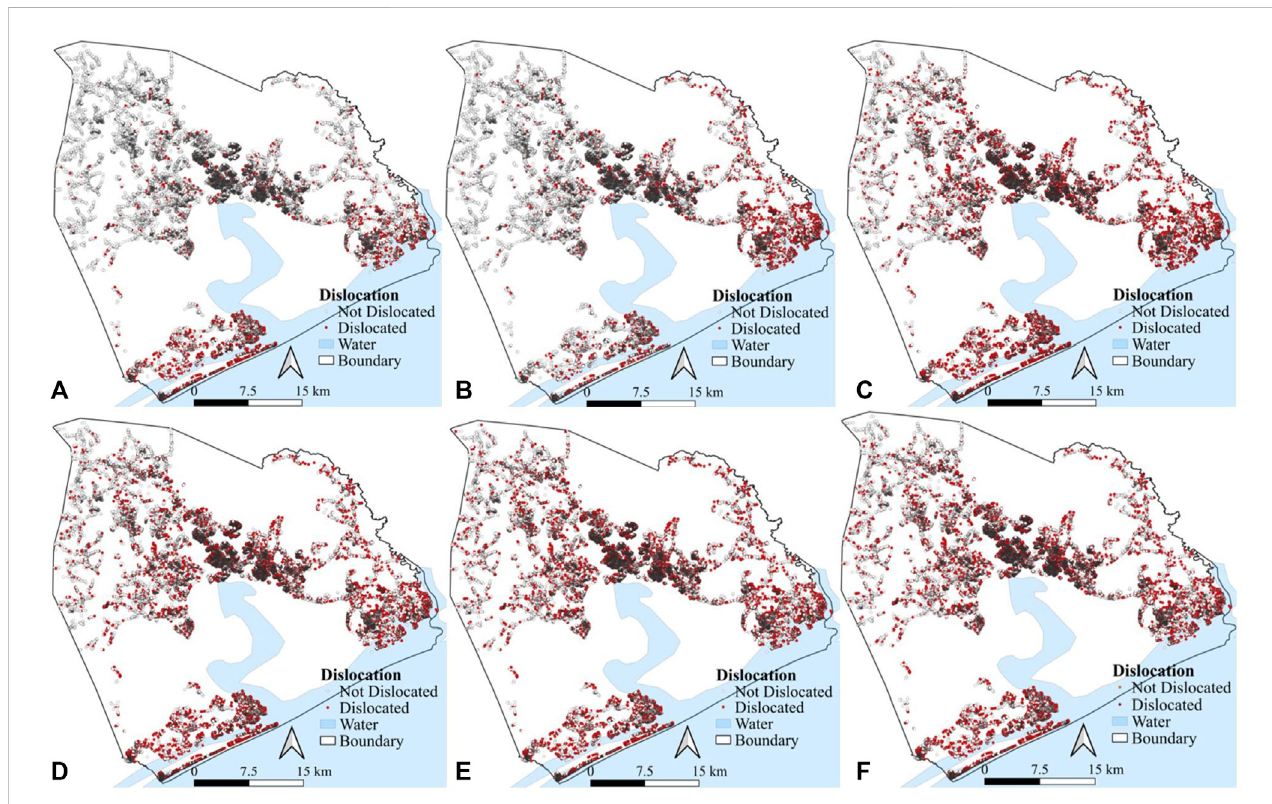
FIGURE 12 Household dislocation map for hurricanes: (A) P1, (B) P2, (C) P3, (D) P4, (E) P5, and (F) Helene.